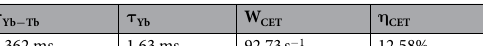
Table 3. Forward energy transfer data (2Yb 3 + : 2 F 5/2 → Tb 3 + : 5 D 4 ).